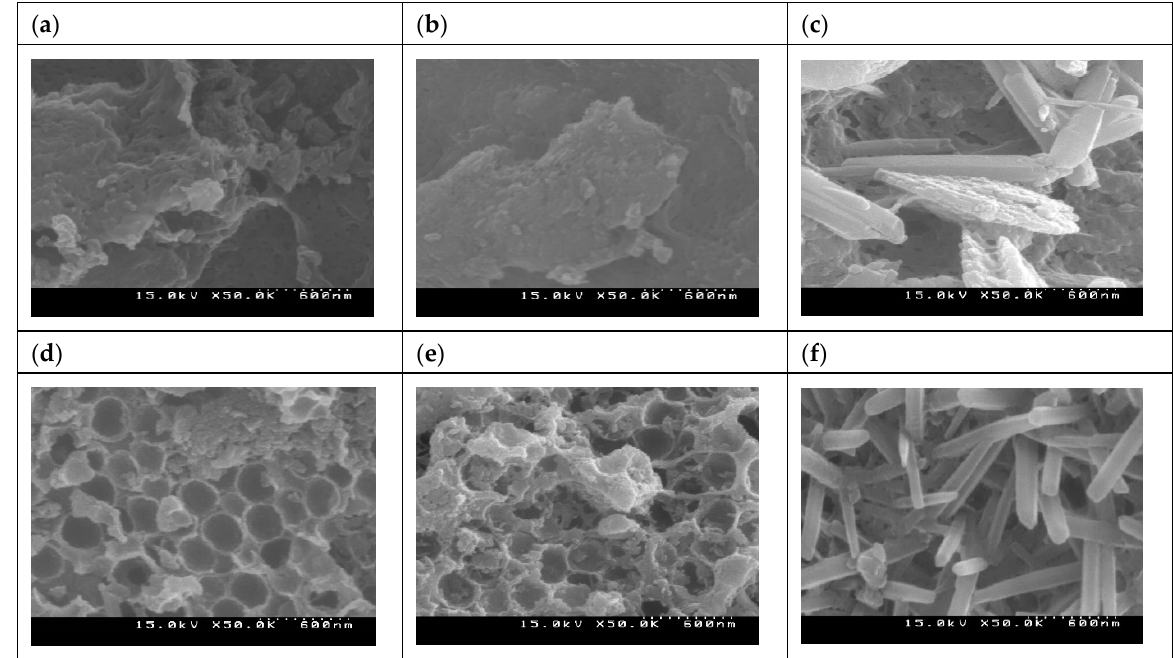
Figure 8. SEM images of Cu-based desulfurization sorbents: ( a ) 5 wt % CuO/r-Al 2 O 3 ; ( b ) 10 wt % CuO/r-Al 2 O 3 ;